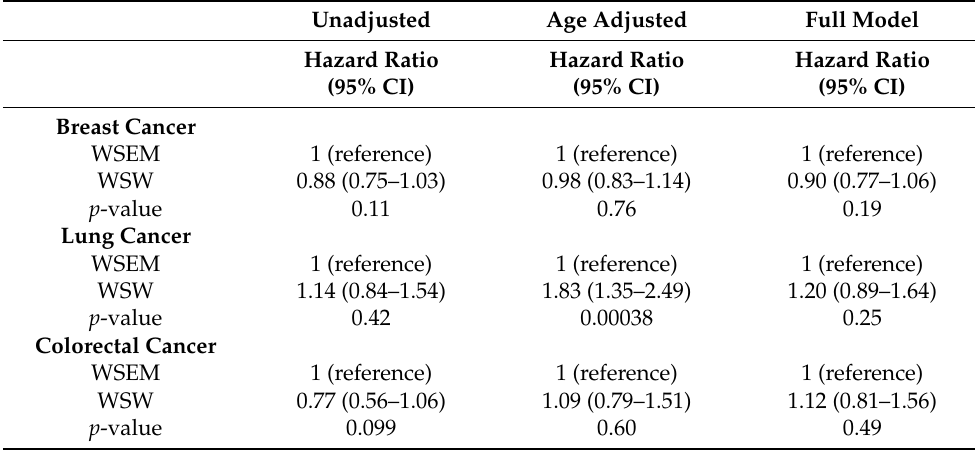
Table A5. Models of breast, lung, and colorectal cancer in women.